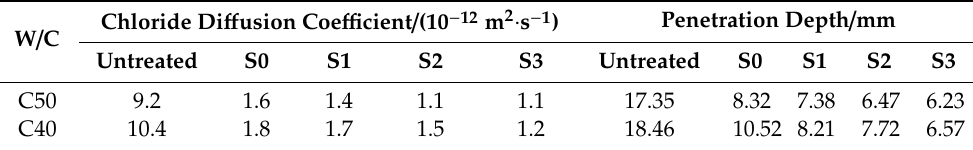
Figure 6. E ff ect of SiO 2 sol / silane emulsion with di ff erent programs on chloride profiles in concrete: ( a ) C50; ( b ) C40. Table 5. E ff ect of SiO 2 sol / silane emulsion with di ff erent programs on chloride penetration and di ff usion coe ffi